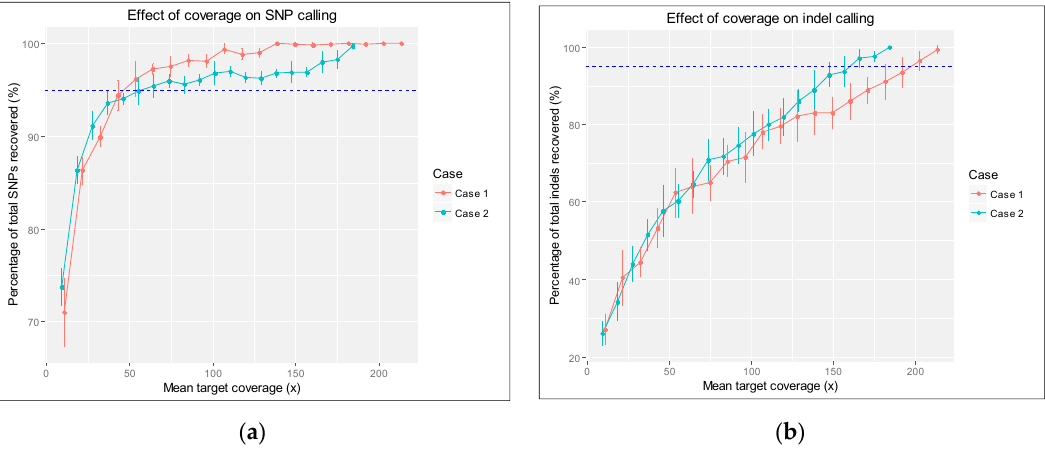
Figure 2. Effect of sequencing coverage on ( a ) SNP and ( b ) indel calling. Error bars represent standard deviation of percentage of SNP and indel recovered at each level of coverage, calculated from 10 replicates. The dashed line (in blue) denotes an arbitrary 95% threshold of the total number of variants recovered, using the variant calls from the full sequencing data as the pseudo-truth set.